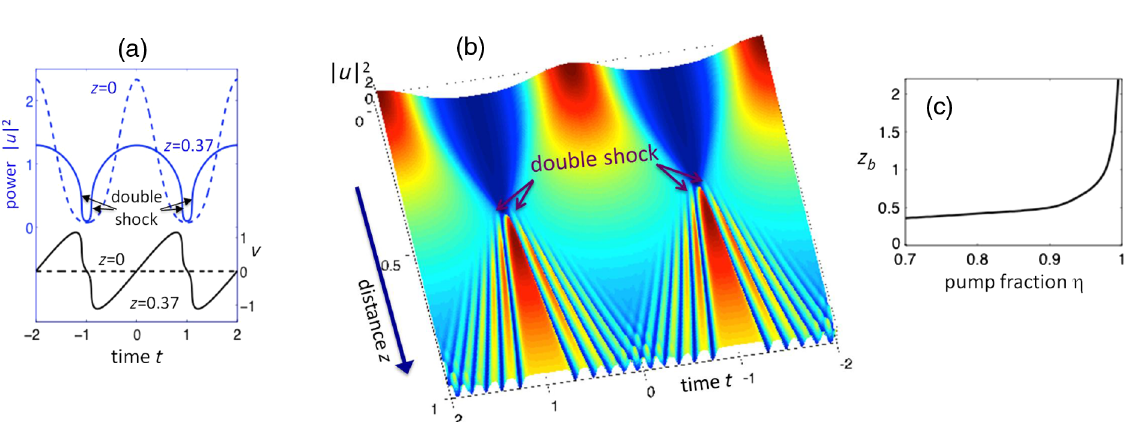
FIG. 2. Breaking mechanism for an input modulated carrier (three-wave input, η ¼ 0 . 8 and α ¼ 0 ). (a) Normalized power ρ ¼ j u j 2 and ≃ 0 . 37 from the reduced hydrodynamical model [Eqs. (3)]; the dashed curves stand for the velocity v at wave-breaking distance z ¼ z b input. (b) Surface plot of power j u ð z; t Þj 2 evolving according to the NLS equation [Eq. (2)] for ε ¼ 0 . 04 . (c) Normalized breaking distance z vs pump power fraction η b